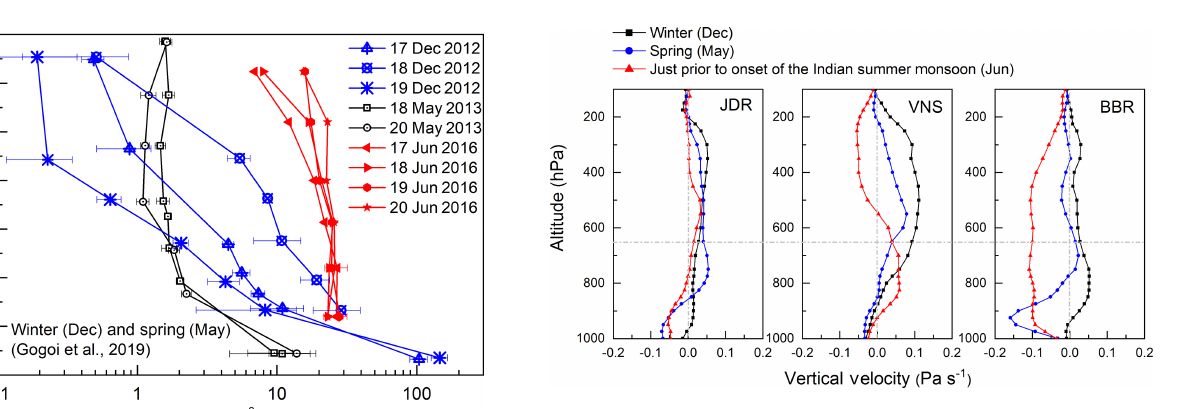
Figure 16. Vertical profiles of vertical velocity (Pas − 1 ) over the study locations representing winter (December 2012), spring (May 2013) and just prior to the onset of the Indian summer monsoon (June 2016) at different pressure levels from 1000 to 100hPa. The positive and negative values are indicative of the descending and ascending motions, respectively. The horizontal dashed line indi- cated the ceiling altitude ( ∼ 3 . 5km above ground level) of aircraft measurements while the vertical dashed lines mark the boundary of vertical velocity ( = 0) changing from positive to negative and vice